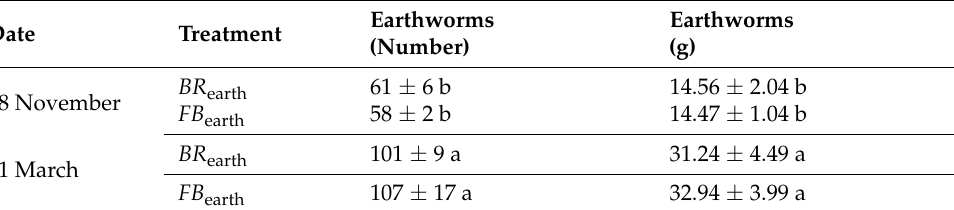
Table 1. The number and total weight of earthworms were measured at the beginning and at the end of the trial in soils under different treatments, consisting of broccoli with earthworms ( BR earth ) and faba bean with earthworms ( FB earth ). Each value represents the mean (± SD) from four measurements ( n = 4). Means followed by different letters within columns are significantly different at a 5% probability level (Tukey’s HSD test).